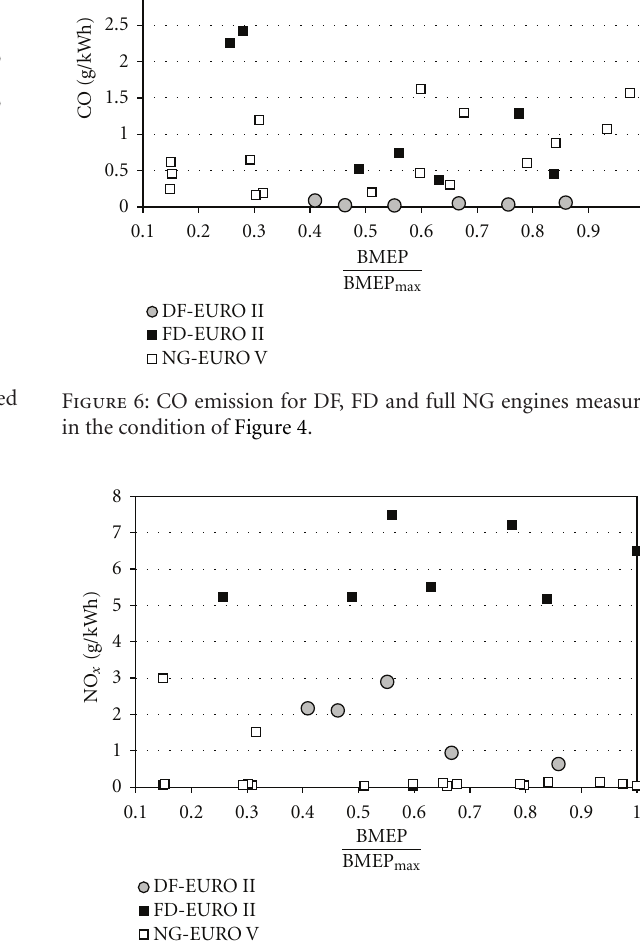
Figure 5: THC emission for DF, FD and full NG engines measured in the condition of Figure 4.